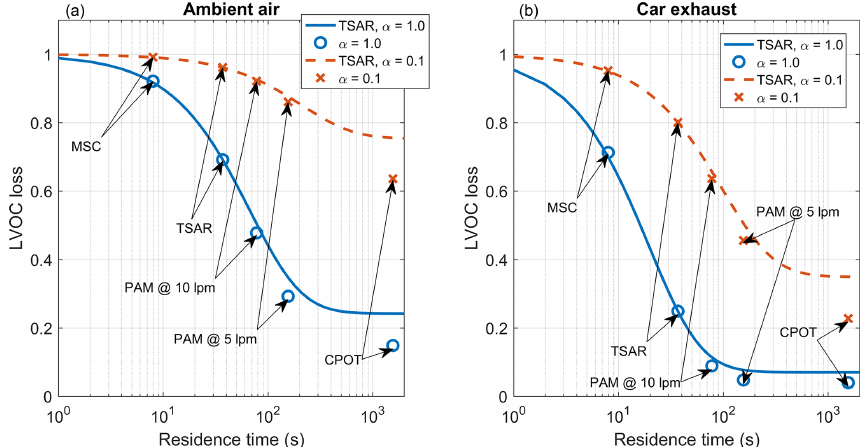
Figure 7. Modeled losses of low-volatility organic compounds as a function of residence time in TSAR in the case of ambient air (a) and vehicle exhaust measurement (b) using two values for the accommodation coefficient ( α) . The model results for other flow reactors are also shown using typical residence times.